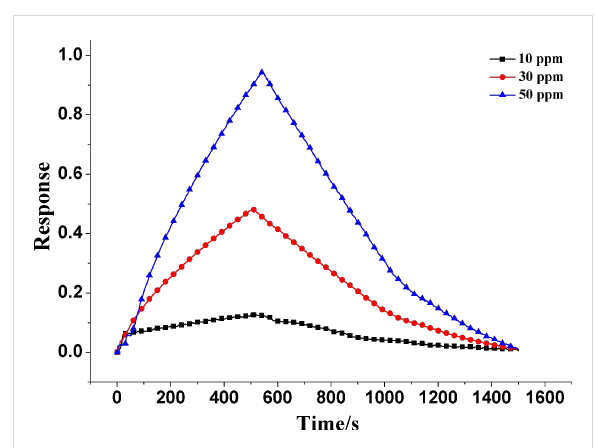
Figure 7: Dynamic response of In 2 O 3 / PANI-2 sensor towards 50 ppm, 30 ppm and 10 ppm NH 3 at room temperature.